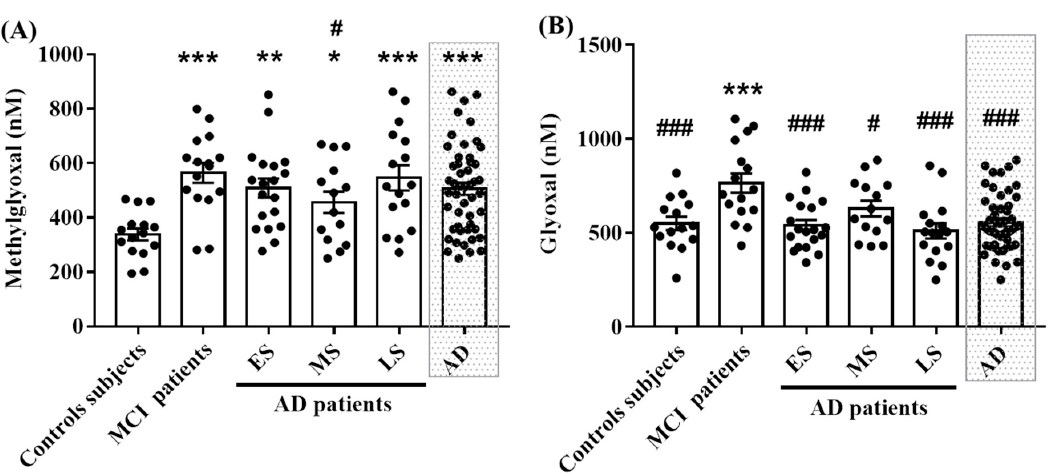
Figure 1. Levels of MG and GO in serum from control, MCI and different AD groups. MG ( A ) and GO ( B ) serum levels are expressed in nM. Each point represents the value obtained from one patient or control subject. The difference between groups was analyzed with one-way ANOVA followed by the LSD post hoc test. Values are mean ± S.E.M with * p < 0.05, ** p < 0.01, *** p < 0.001 versus control subjects. # p < 0.05, ### p < 0.001 versus MCI patients.